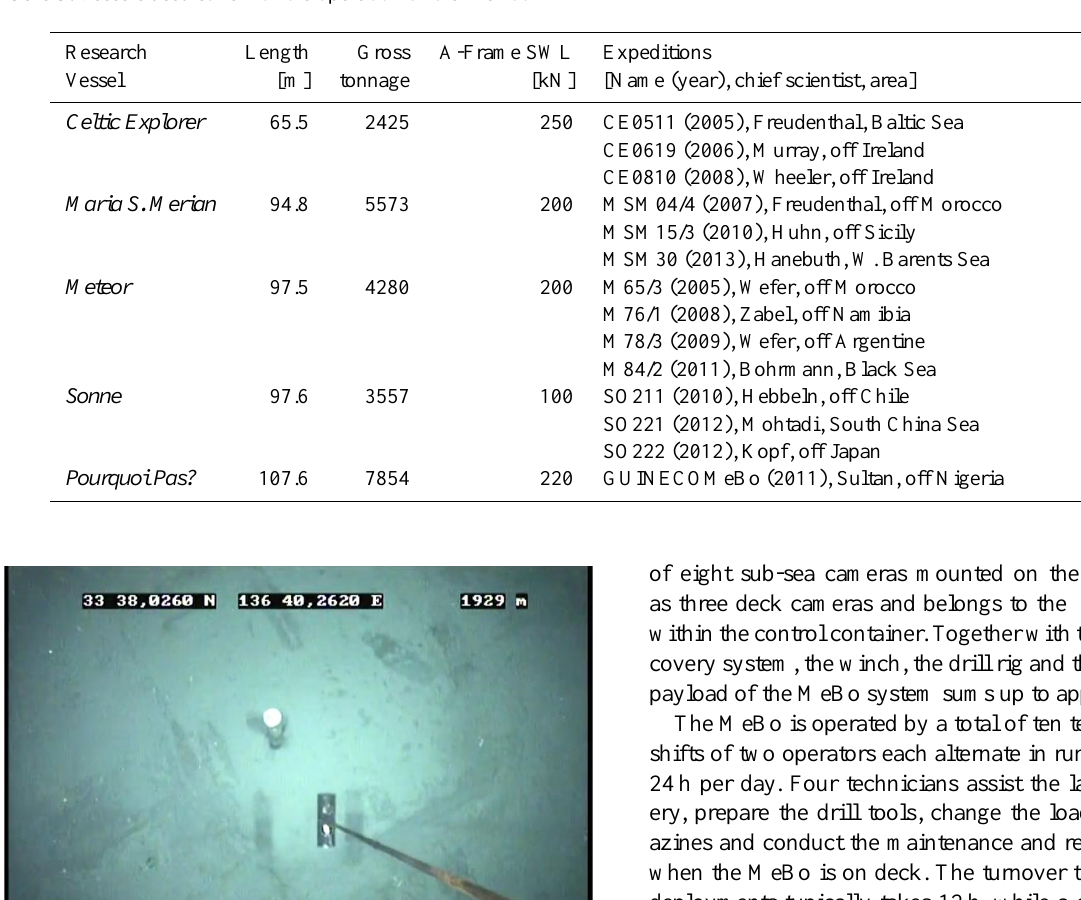
Table 3. Vessels used so far for the operation of the MeBo.